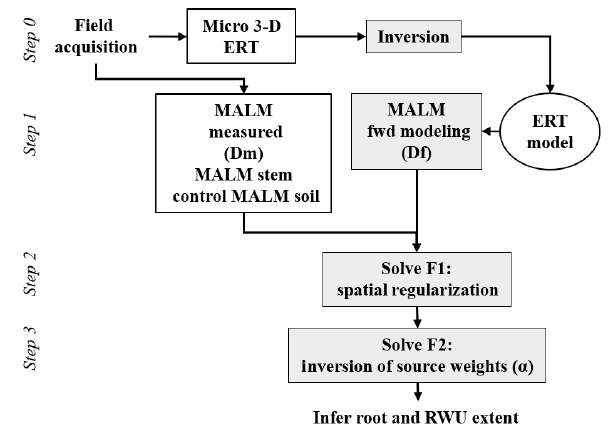
Figure 3. Flow chart of the analysis of MALM as described in this paper, from data acquisition, processing and interpretation in terms of RWU region